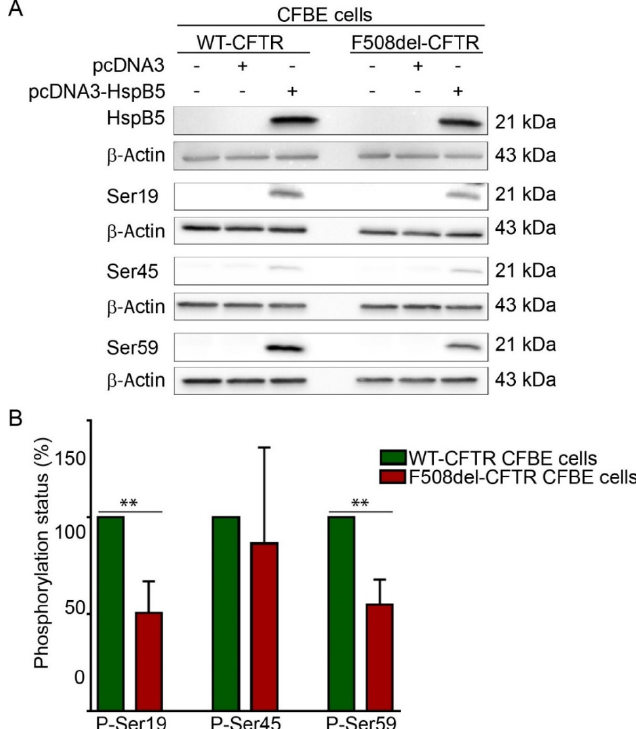
Figure 2. Determination of HspB5 phosphorylation status. ( A ) Western blotting using the phospho